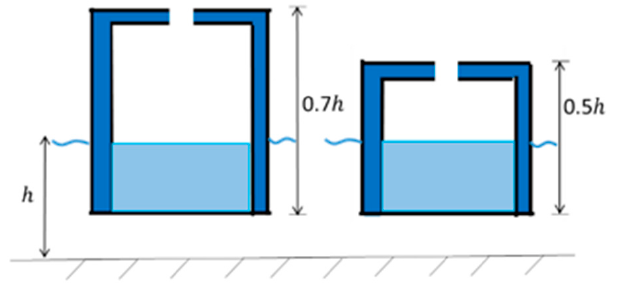
Figure 15. The variation of the height of the OWC in scaled-down model structure.